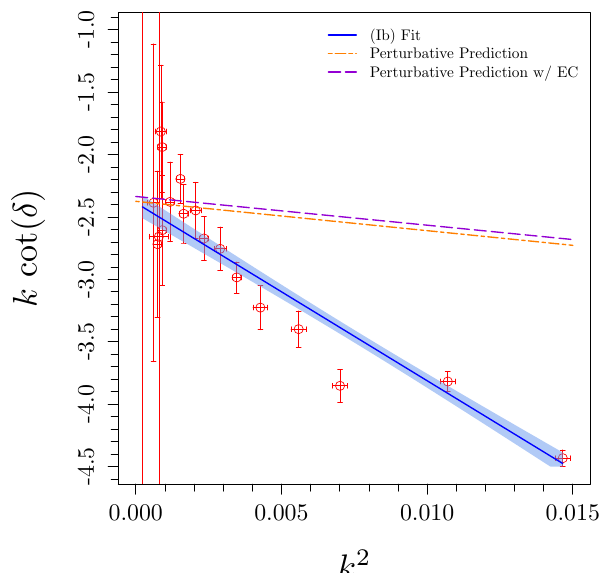
Figure 10. Comparison of the phase-shift fit using model (Ib) with perturbative predictions. The latter are computed by the scattering length extracted from the ∆ E 2 energy shift fits to order L − 5